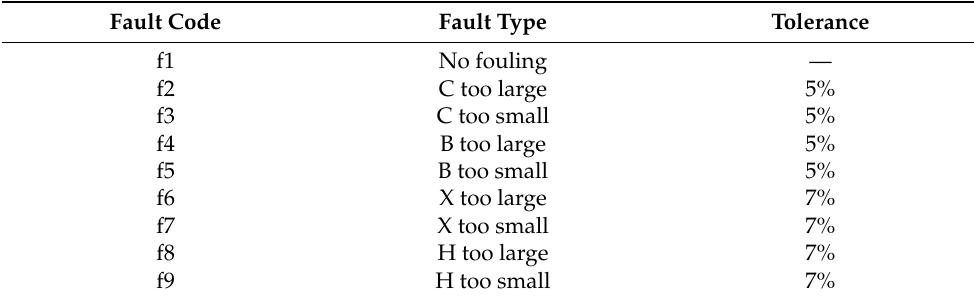
Table 1. Membrane fouling mode of the membrane